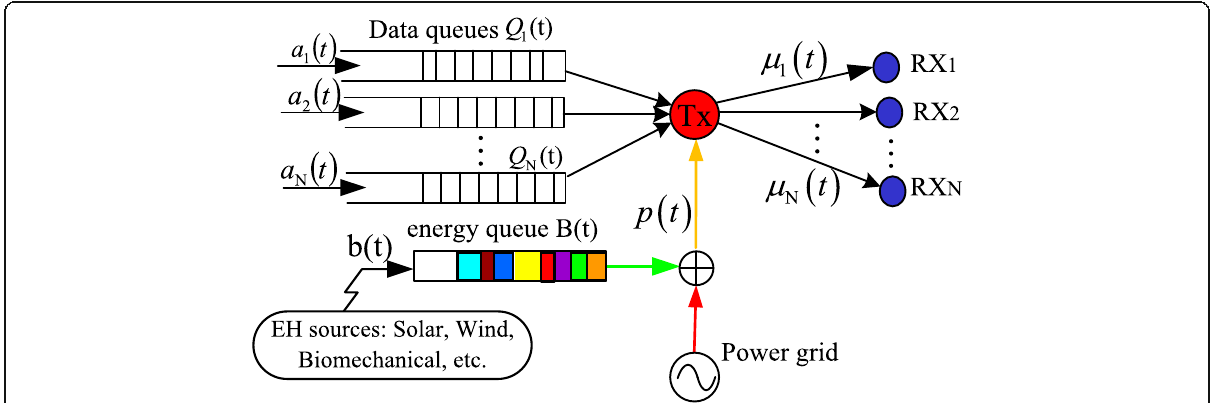
Fig. 2 Multiuser EH transmitter supplied by hybrid energy sources in fading channels